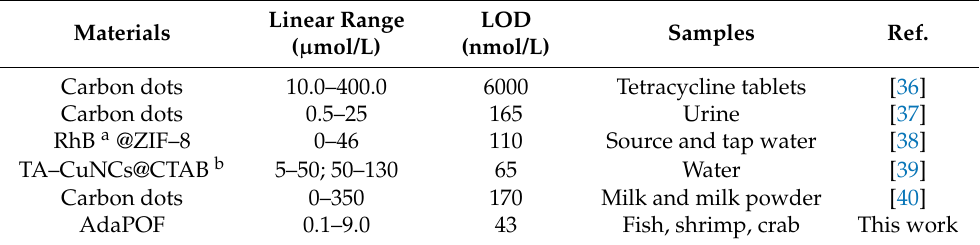
Table 2. Comparisons of different fluorescence methods in the determination of